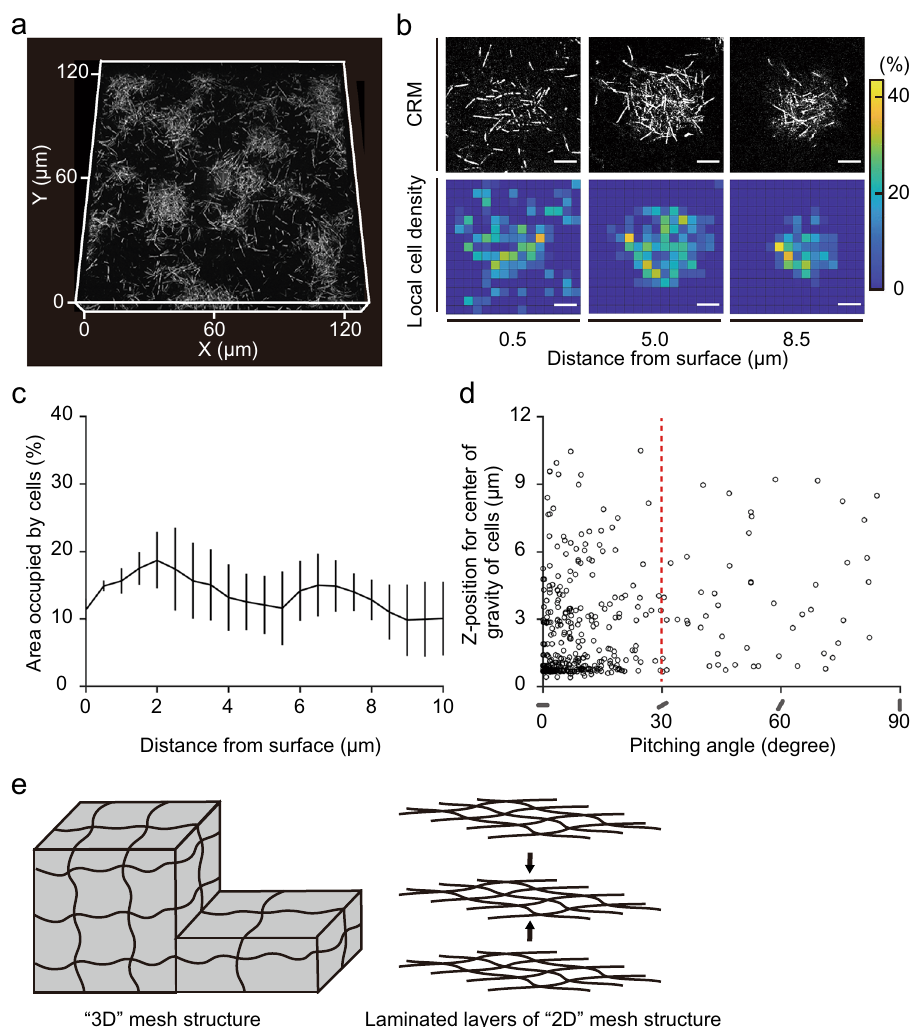
Figure 6. Structural characteristics of P. aeruginosa PAO1 WT biofilms formed on the MY-133-EA layer under denitrifying conditions. ( a ) The 3D projection of the biofilms grown under denitrifying condition for 22 h. The images were obtained by optical system equipped with a 561-nm continuous wave laser, a 100 × oil-immersion lens (NA = 1.45, RI = 1.515) and a pinhole of 0.7 AU. The z-resolution is 0.4 μm. Note that deterioration of NA by IMM was not taken into account to calculate resolution. The projection depicts the range of 17.5 μm along the vertical z-axis. ( b ) Optical slice images within microcolony (upper panels) and local cell density presented as a heatmap (lower panels). Numbers below the panels denote the distance from the surface. Bars are 6 μm and the matrix size for the heat maps is 2.4 μm × 2.4 μm. ( c ) Average area occupation rate by cells in the representative microcolony (n = 3). The x-axis denotes the distance from the surface. Error bars denote SDs. ( d ) Pitching angles of individuals cells ( ○ ) in the microcolonies relative to the horizontal plane. The y-axis denotes the z-position for the center of gravity of cells, where zero indicates the surface. ( e ) Schematic illustration of the “3D mesh” structure (left) and laminated layers of the “2D mesh” structure